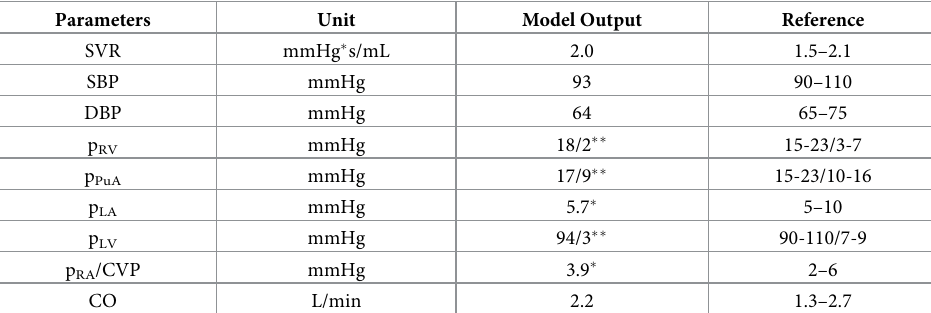
Table 1. Comparison of model outputs with literature data specific for the paediatric case given as physiological ranges [18].